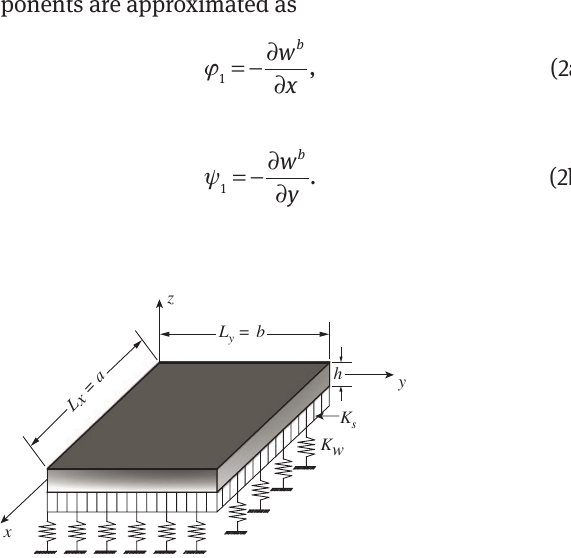
Figure 1: The FG plate supported on elastic